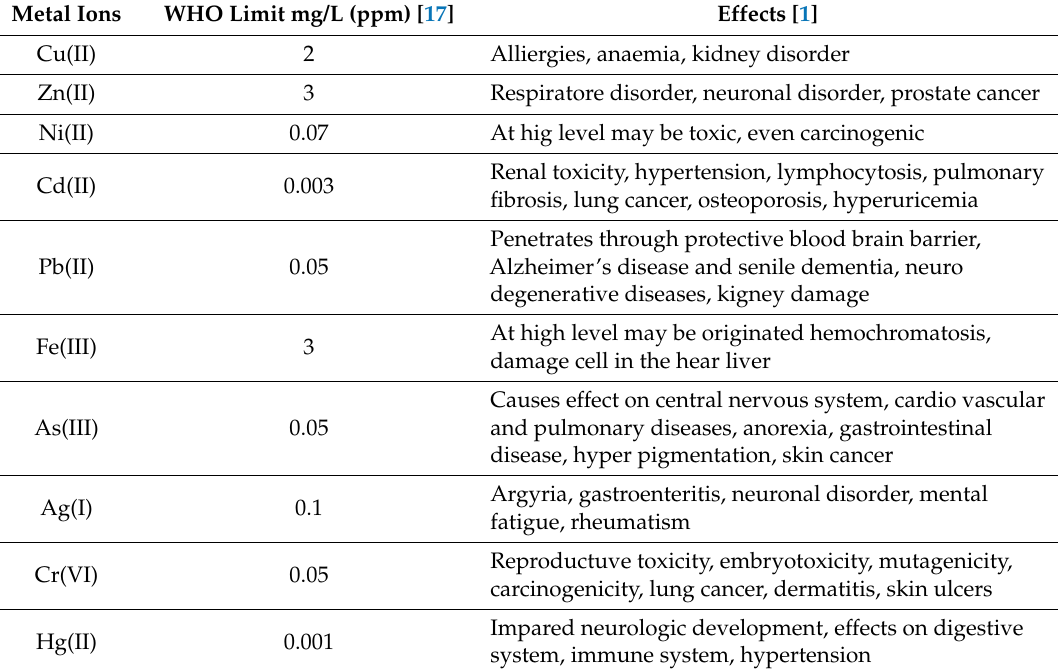
Table 1. Limit of various heavy metal ions in drinking water according to World Health Organiztion